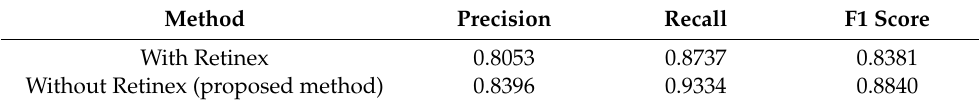
Table 4. Performance comparisons with or without Retinex filtering.